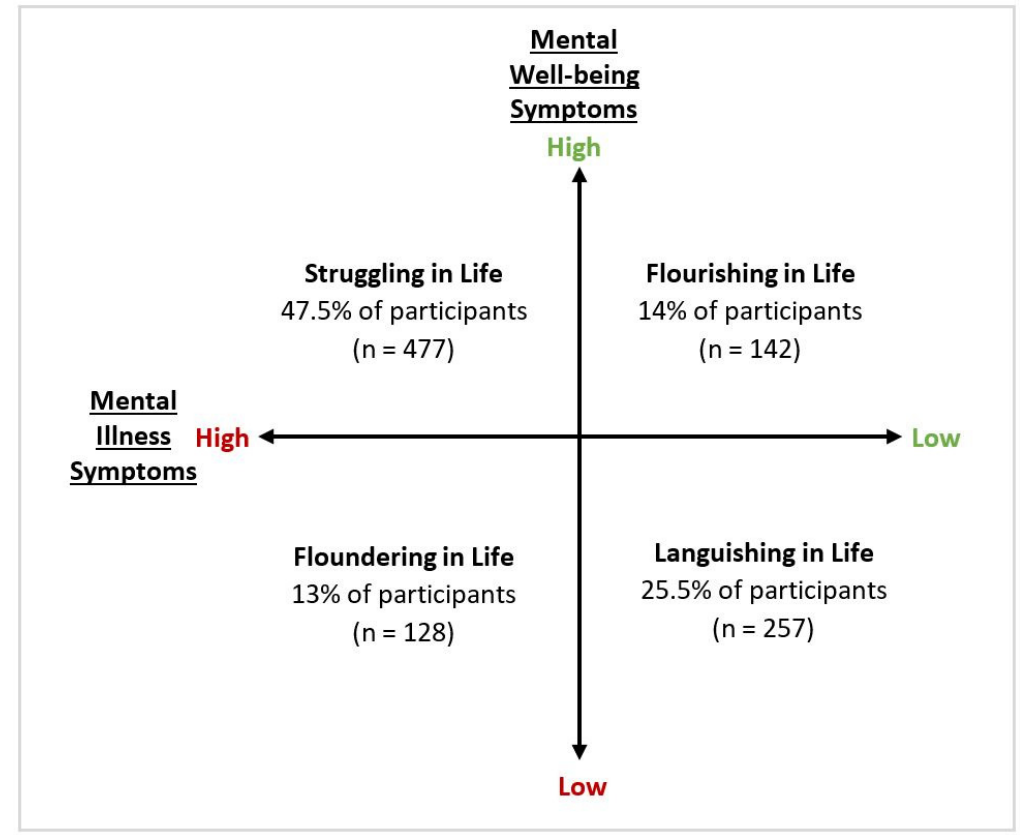
Figure 1. Proportion of sample cross-classified into each of the Complete State Model of Mental Health [44,45,47,48] mental health states during the COVID-19 pandemic. Table 2. Sociodemographic variables by mental health state.